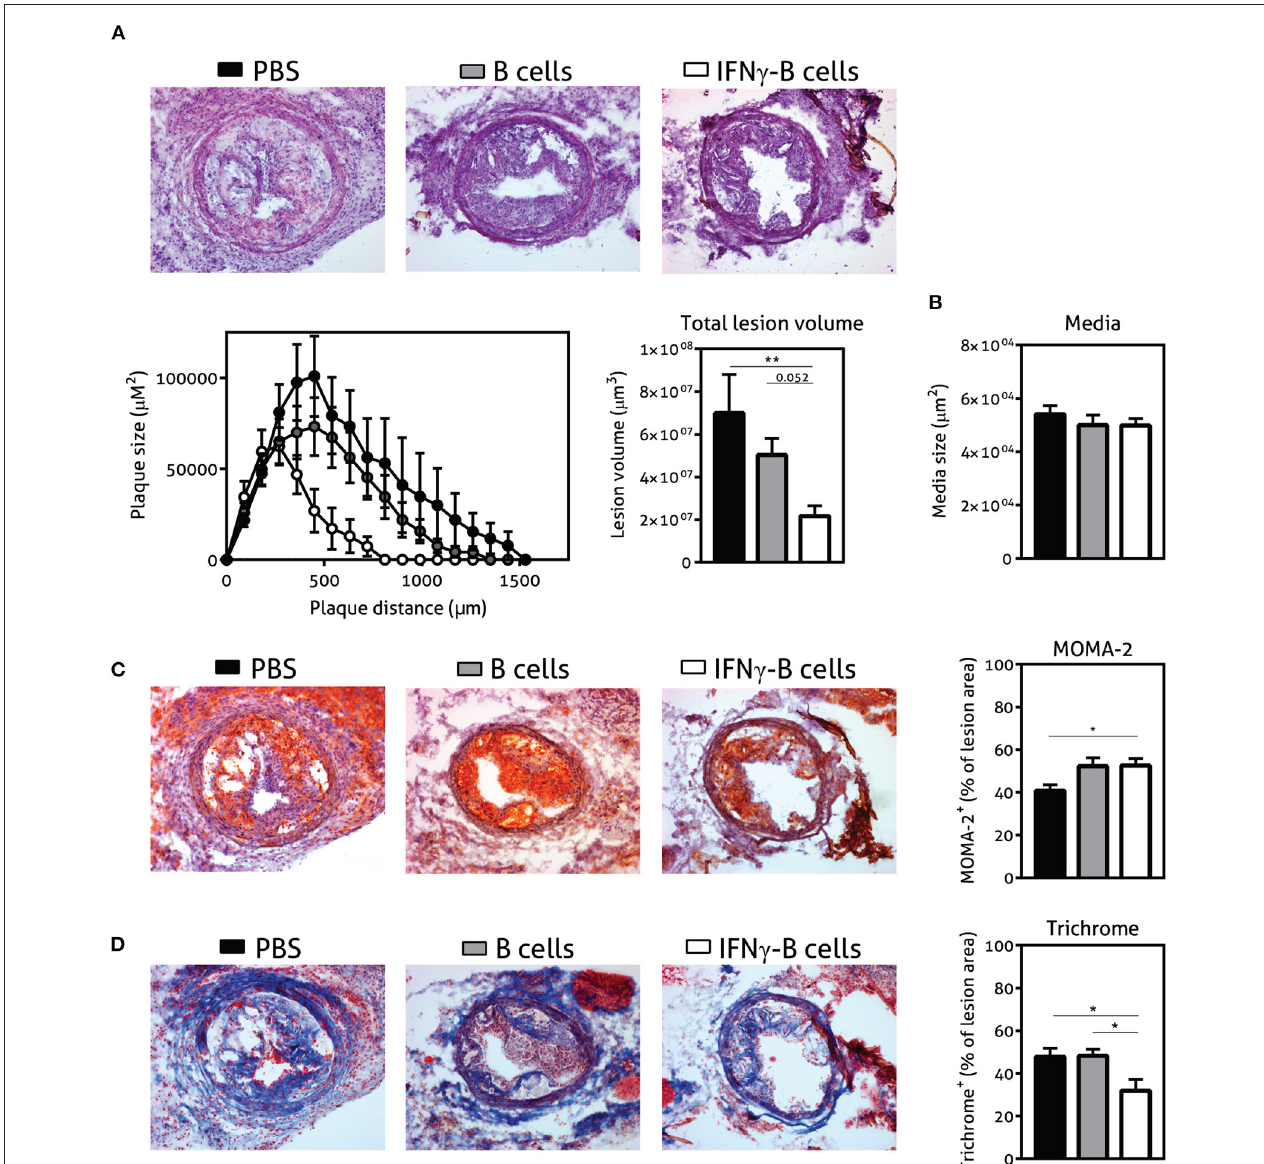
FIGURE 5 | Adoptive transfer of IFN γ -B protects against atherosclerosis . ApoE − / − mice were fed a Western type diet for 7 weeks. After 2 weeks they received a perivascular collar and were treated with PBS, freshly isolated B cells (B cells) or B cells stimulated with 20.0ng/ml IFN γ for 24h (IFN γ -B cells). Mice received a total of three injections and injections were spaced every two weeks. After 7 weeks, mice were sacrificed and (A) total lesion volume and (B) media size was determined in the right carotid artery with a hematoxylin and eosin staining. Lesion phenotype was determined in sections containing the largest lesions. (C) Macrophage content was analyzed using a MOMA-2 staining. (D) Collagen content was quantified with a Trichrome staining. Data are analyzed with a One-Way ANOVA and shown as mean ± SEM (* p < 0.05, ** p < 0.01). n =